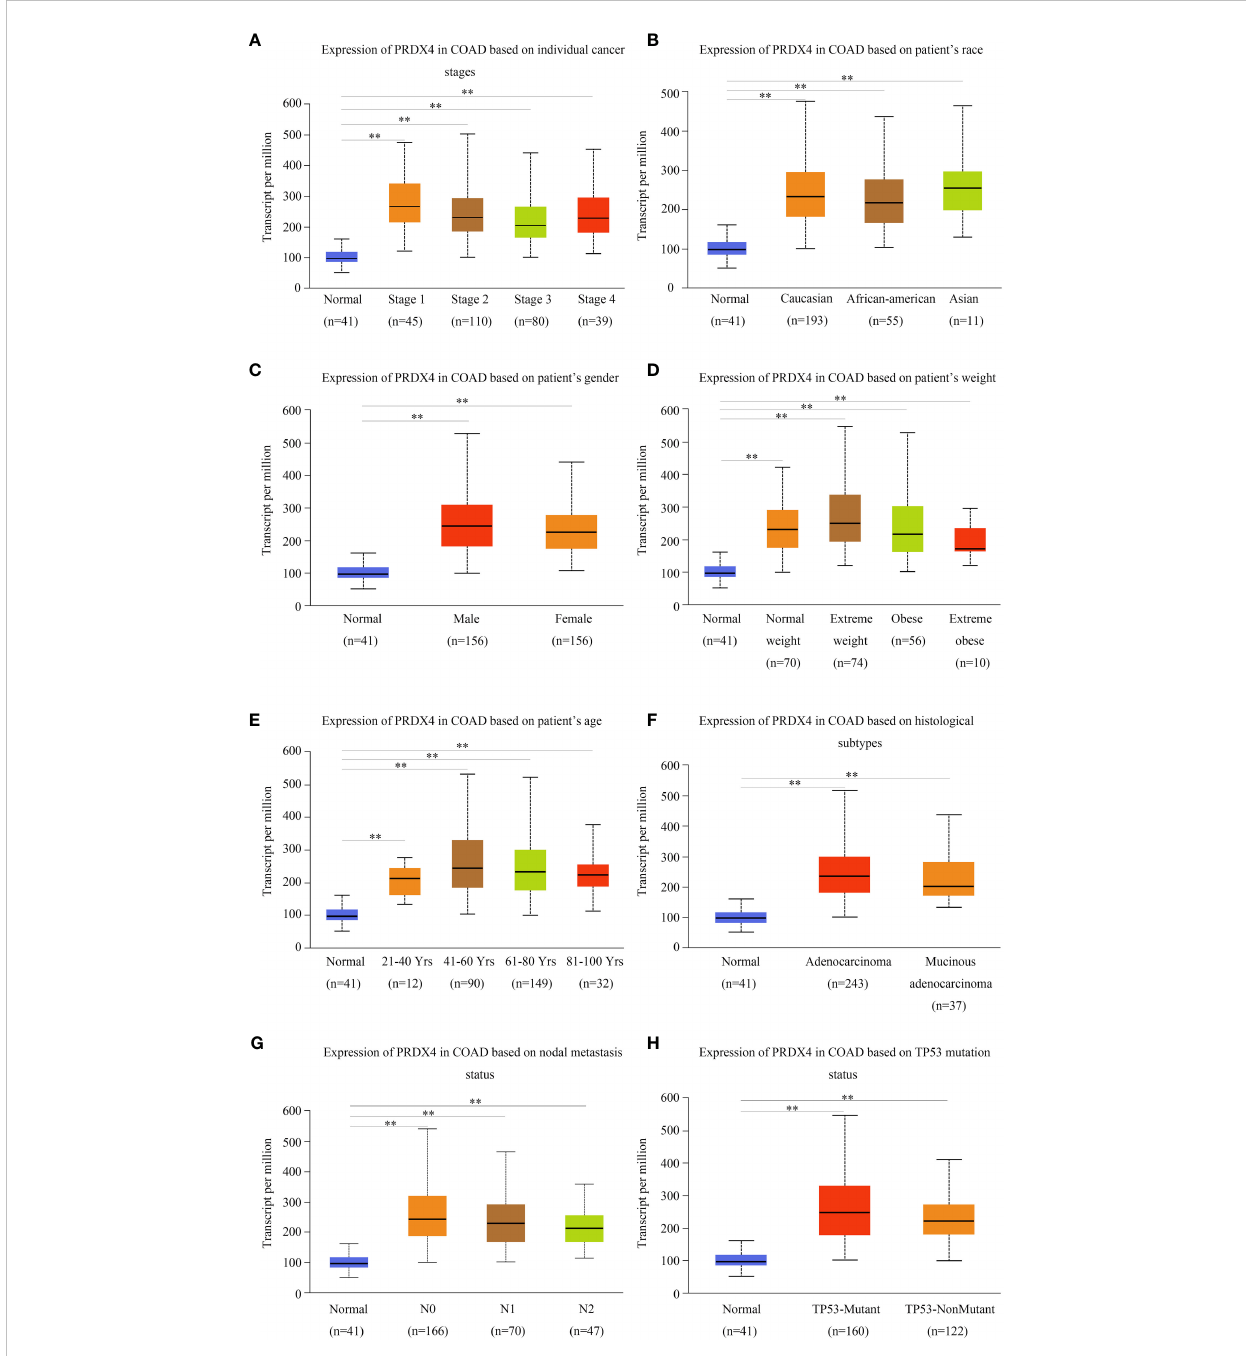
FIGURE 7 PRDX4 transcript levels in subgroups of COAD patients, strati fi ed by individual cancer stages, race, gender, and other criteria (UALCAN). Compared with normal tissues, PRDX4 was highly expressed in all clinical subtypes shown in (A-H) and had a signi fi cant correlation with these clinical characteristics. ** P < 0.01. COAD, colon